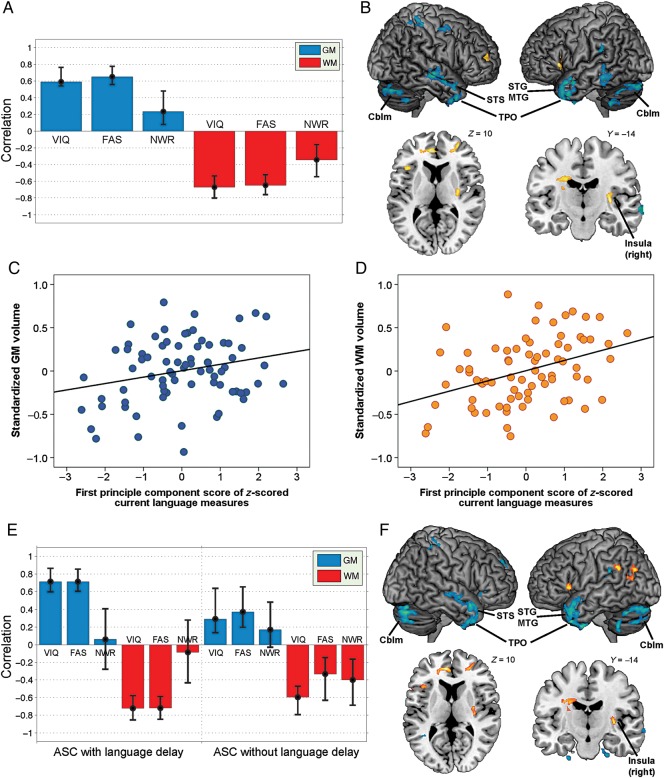
Neuroanatomical correlates of current structural language in ASC. (A) This “correlation overview” graph shows that for the significant LV pair (LV1) revealed by the 1-group PLS analysis, there were stable correlations (i.e., confidence intervals not including zero; error bar representing bootstrap-estimated 95% confidence interval) between the “brain scores” (i.e., the dot-product of the brain LV saliences and the individual's imaging data, giving an overall summary of the brain data for each individual) (McIntosh and Lobaugh 2004) and all 3 language measures. This also illustrates that overall the correlation between the “brain scores” and language performance was contributed by opposite directions of correlation for the GM and WM “conditions.” (B) Different sets of brain regions, altogether, contribute to LV1 in the 1-group PLS analysis, visualized at the thresholds of voxels with a ︱bootstrap ratio︱> 2.5 and clusters larger than 400 voxels. Blue/green regions (mostly in GM) show the most reliable voxels with “positive” saliences (bootstrap ratios), where language performance was positively correlated with a higher probability being GM than WM voxels, suggestive of larger GM volume; orange/yellow regions (mostly in WM) show the most reliable voxels with “negative” saliences, where language performance was positively correlated with a higher probability being WM than GM voxels, suggestive of larger WM volume. (C and D) Scatter plots conceptually illustrate the relationships described in (B) for the sets of brain regions contributing to LV1. Panel (C) demonstrates the positive correlation between current language ability and age-standardized relative GM volume for brain regions with positive saliences; panel (D) demonstrates the positive correlation between current language ability and age-standardized relative WM volume for brain regions with negative saliences. X-axis indicates the first principle component score of z-scored language measures, a summary index for overall current language ability. Y-axis in (C) indicates the average age-standardized relative GM volume from the blue/green regions in (B), and in (D), the average age-standardized relative WM volume from the orange/yellow regions in (B). Panels (E) and (F), parallel to (A) and (B), show the correlation overview and neural systems in the significant LV pair (LV1) revealed by the 2-group PLS analysis. (E) demonstrates that the brain–behavior correlation patterns were overall similar between those with and without a history of language delay. (F) shows the spatial involvement of LV1 from the 2-group PLS analysis [visualized at the same thresholds as in (B)], which involves mostly the same structures as those of the LV1 from the 1-group PLS analysis. Cblm, cerebellum; MTG, middle temporal gyrus; STG, superior temporal gyrus; STS, superior temporal sulcus; TPO, temporal pole.